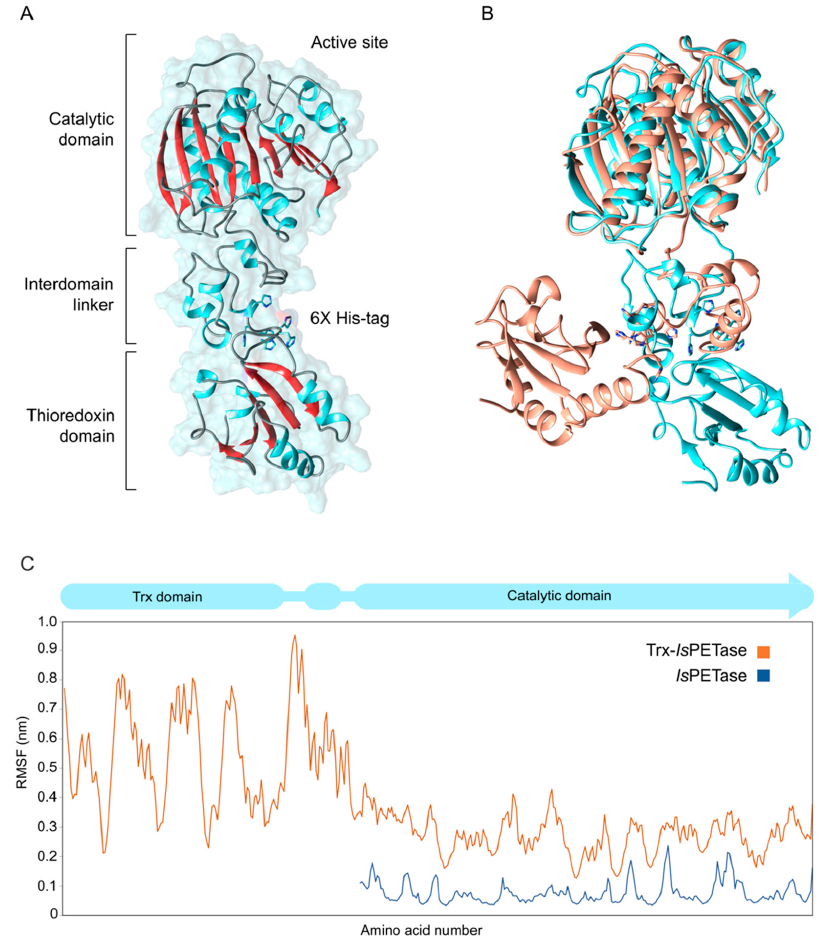
Figure 6. Molecular structure and dynamics of Trx- Is PETase. ( A ) Average molecular model of Trx- Is PETase after 500 ns of molecular dynamic simulations. ( B ) Overlapped structures of Trx- Is PETase before MD simulations (in orange) in closed form and average structure (in cyan) in open form. ( C ) RSMF analysis of Trx- Is PETase and Is PETase.